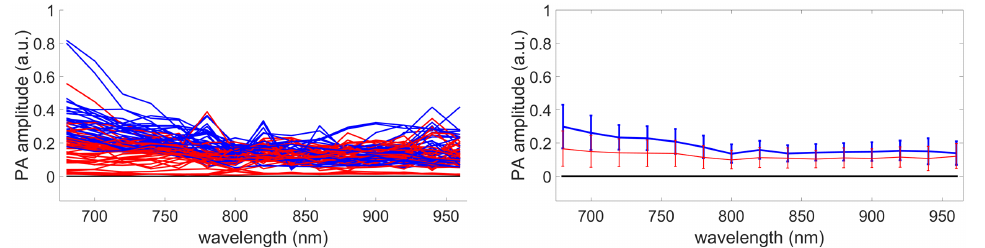
Figure 14. Endmembers extracted with GLUP. Left column: sets of extracted endmembers. Right col- umn: mean spectra and standard deviations.